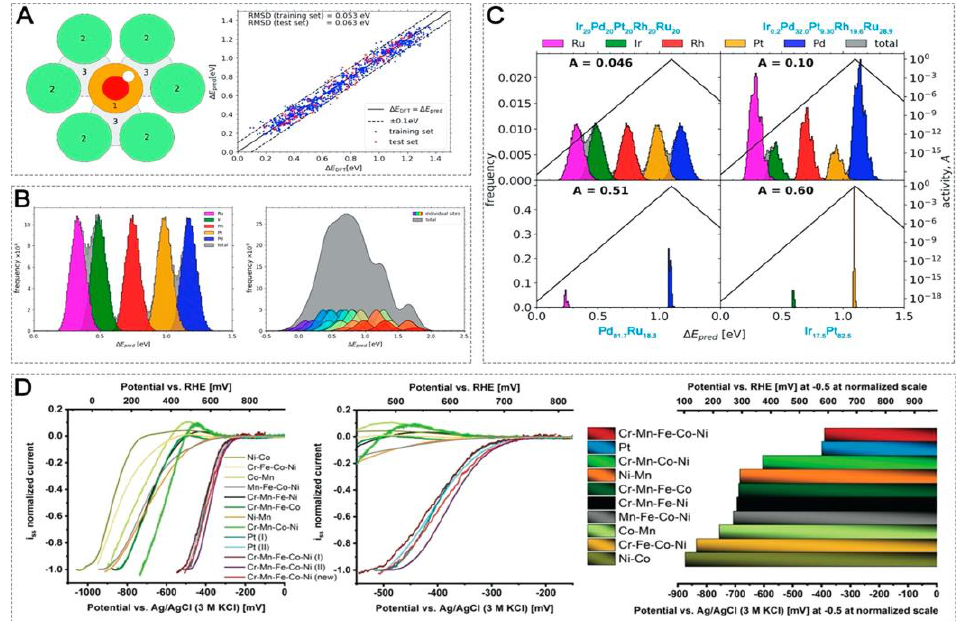
Figure 17. ( A ) OH* adsorbed on HEA. Each colored area represents an adjacent shell with a set of five parameters; the OH* adsorption model was trained on 871 specimens (blue dots) and tested on 76 specimens (red crosses). ( B ) OH*, and O* adsorption on the HEA model. ( C ) The activity of the redesigned IrPdPtRhRu HEA composition [40]. ( A – C ) Reproduced with permission from reference [40]. ( D ) Comparison of the intrinsic activity of different catalysts for ORR. (Reprinted with permission from [241]. Copyright 2020, American Chemical Society).